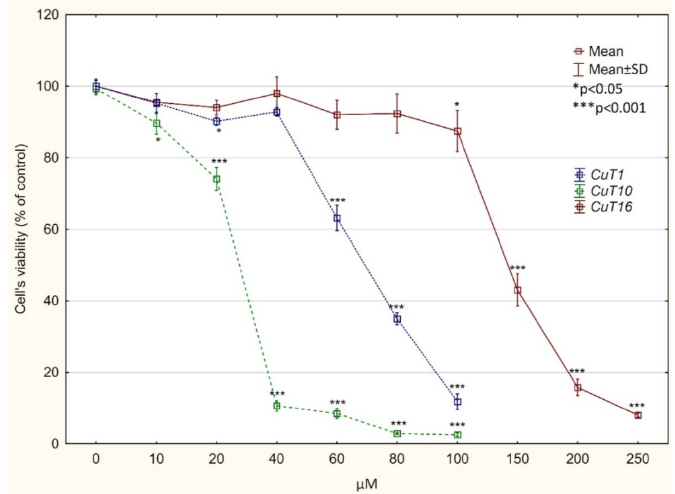
Figure 4. Viability of A375 cells, treated with CuT1, CuT10, and CuT16 compound or DMSO as vehicle in control culture for 24 h (determined by MTT test). Data presented as % of control culture viability (mean ± SD).